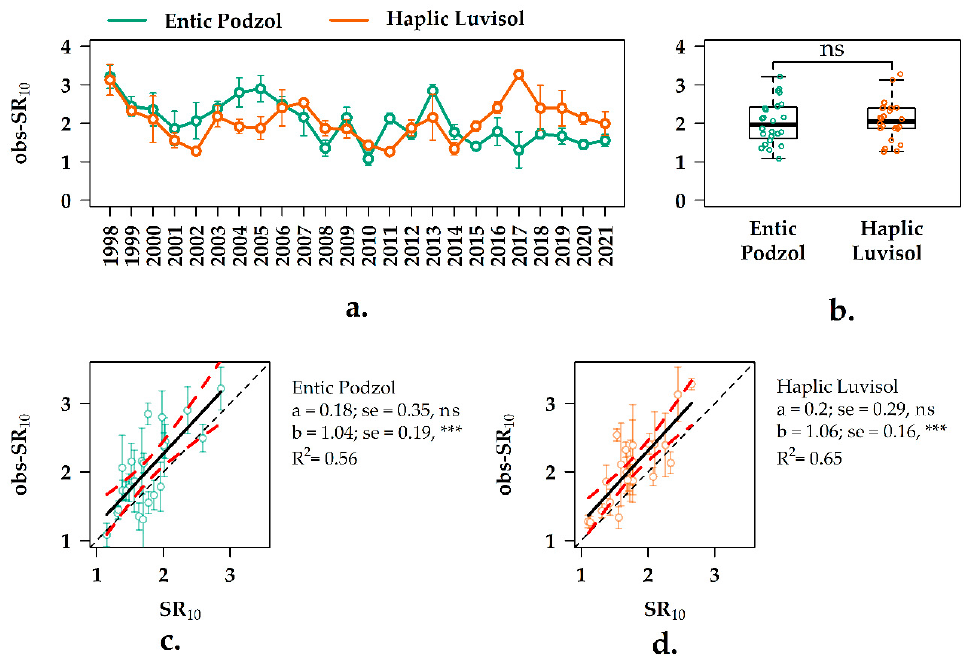
Figure 6. Dynamics of obs-SR 10 values (gCm − 2 day − 1 ) in the two forests during the observation period ( a , c ) and their statistical characteristics ( b ): the median (bar), lower (Q1) and upper (Q3) quartiles (“boxes”); X1 = Q1 − 1.5 IQR (interquartile range = Q3 − Q1) and X2 = Q3 – 1.5 IQR (“moustaches”). All data are shown as dots. ns—the difference between mean values is not significant. Relationship between obs-SR 10 and SR 10 for both forest soils ( c , d ). ***—the parameters of regression equation are significant at p < 0.0001. ns—not significant. Black solid line is a regression line (significant at p < 0.001). Red dotted line corresponds to the standard error, se). Vertical bars are standard errors (±se).